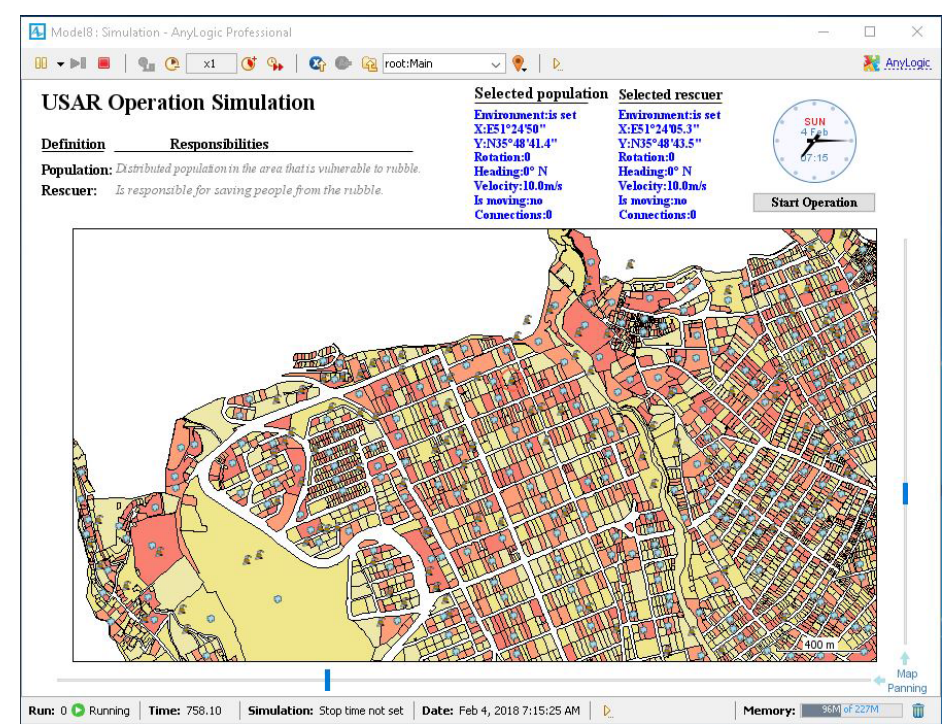
Figure 6. Overview of the USAR simulator. Table 3. Comparison of operation duration in hours between the proposed method and the CNP (based on 30% uncertainty). No. of agents 1000 1500 2000 Simulated earthquake magnitude No. of tasks 28856 Strategy